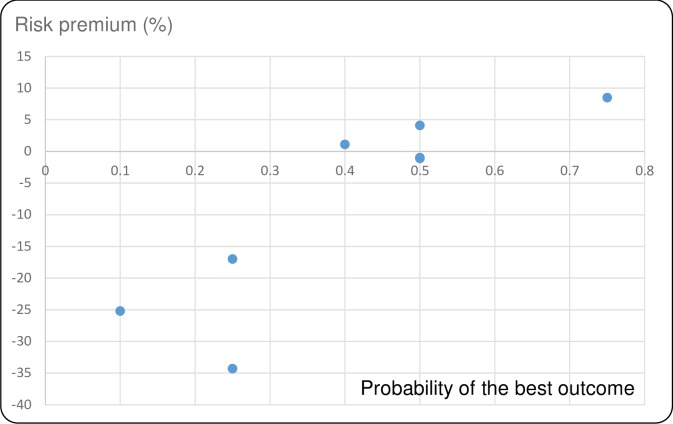
Risk premiums plotted against probability of the best outcome in the gains lottery for FPR.